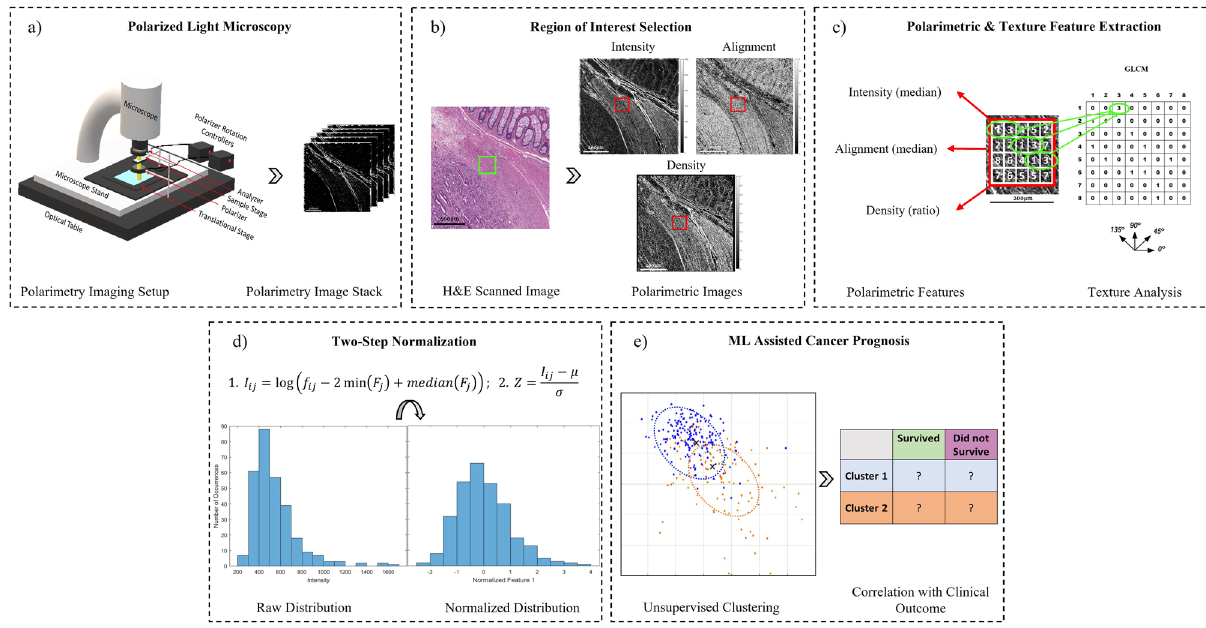
Figure 2. Workflow for proposed polarimetric imaging, analysis, and unsupervised clustering pipeline. ( a ) widefield polarimetric imaging of unstained tissue sample acquired at 18 angular orientations of the crossed linear polarizers (5° increments); ( b ) selection and calculation of novel polarimetric stromal features on the derived Intensity, Alignment and Density images from the 200 × 200 μm ROI identified by pathologist (green square); ( c ) calculation of median polarimetric values and GLCM texture features (contrast, correlation, energy, homogeneity and entropy) within ROI (red square), applied to each of the three derived polarimetric images; ( d ) two-step normalization to ensure feature values are zero-centered and resemble a normal distribution, as needed for clustering model input; ( e ) clustering of the ROIs using the polarimetric and texture features, with the resultant outputs clusters then assessed for correlations with patient